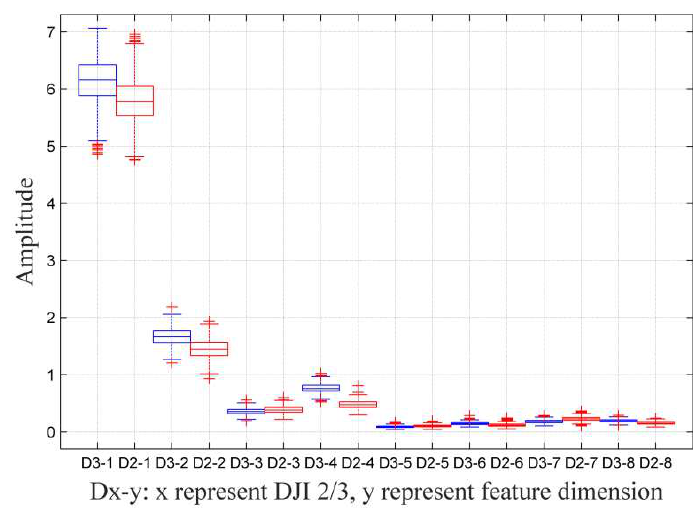
Figure 10. Statistical box diagram of PCA-DWT